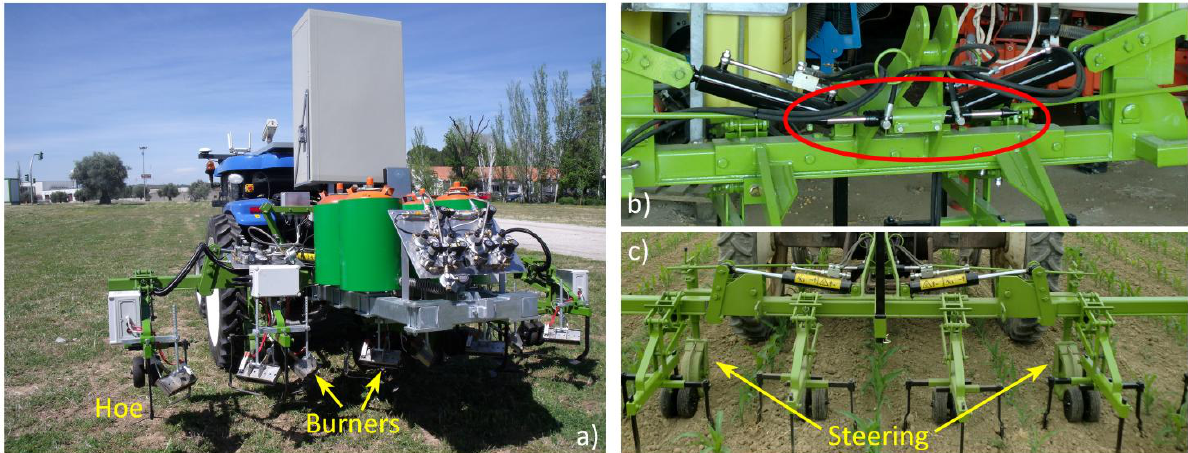
Figure 7. ( a ) Mechanical-thermal machine; ( b ) Implement steering actuator (implement front view); ( c ) Main frame (implement rear